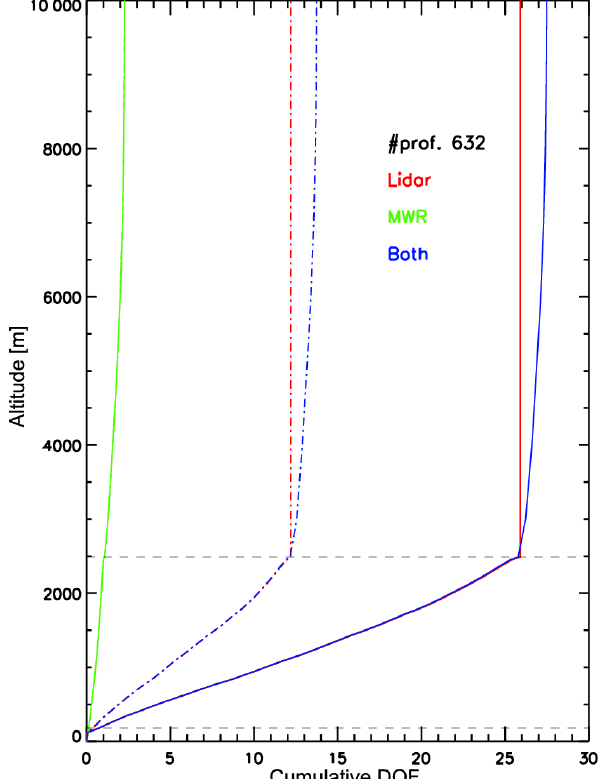
Figure 9. Cumulative degrees of freedom per profile for the differ- ent instrument combinations: in red, only-RL; in green, only-MWR and in blue, MWR+RL. The dotted-dashed lines represent the de- grees of freedom for the case where the RL uncertainty has been multiplied by 4. The average number of DOF in every region are summarized on Table 1. The dashed horizontal gray lines enclose the part of the atmosphere where lidar data have been considered. The number of elements in the measurement and state vectors are 77 (66 for the dashed case) and 91,